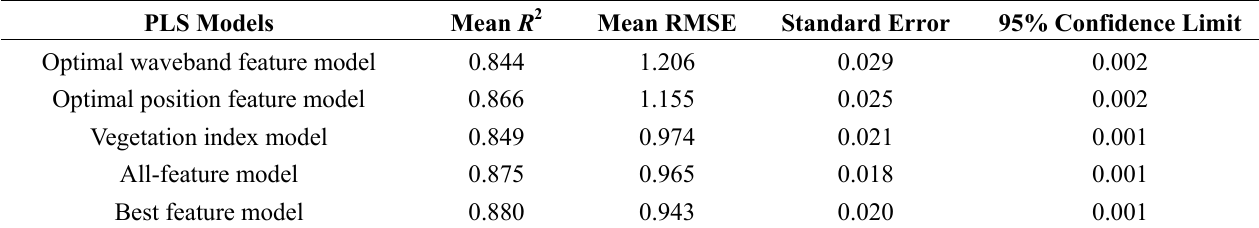
Table 8. Bootstrap methods for PLS models in the independent data